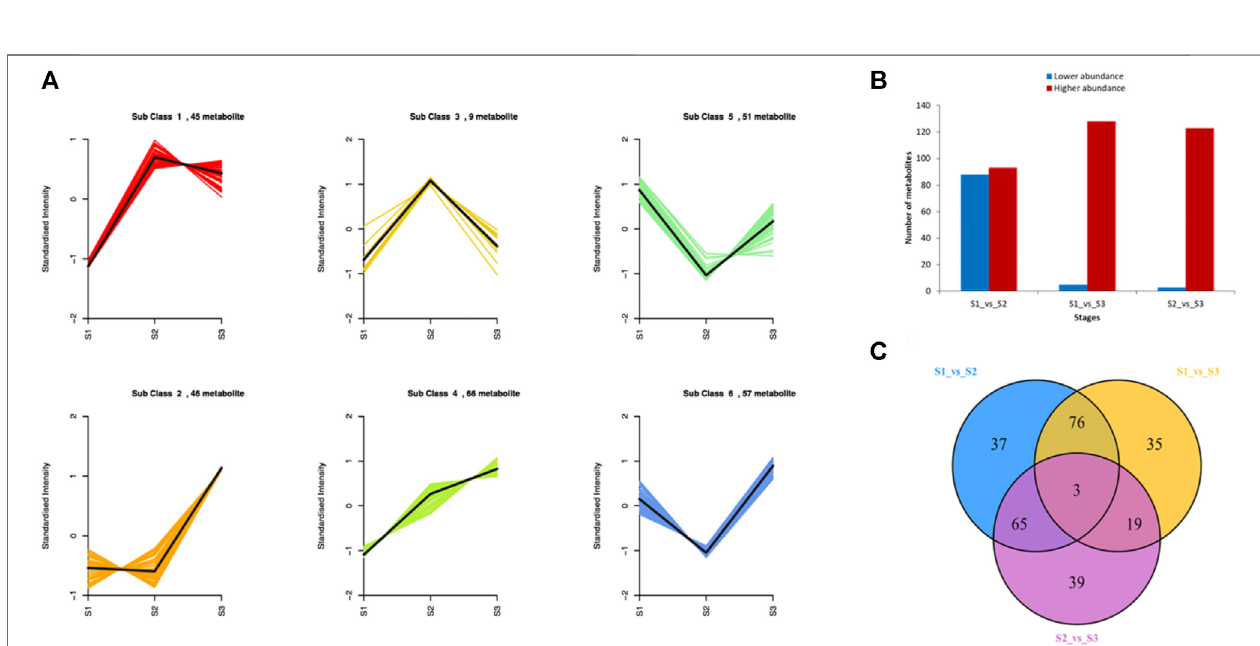
FIGURE 2 | The K-means clustering and statistics of differential metabolites at three developmental stages of M. ternifolia nutshell (A) The clustering results of metabolites (B) Total number of up regulated and down regulated metabolites (C) The distribution of differential metabolites at various development stages.